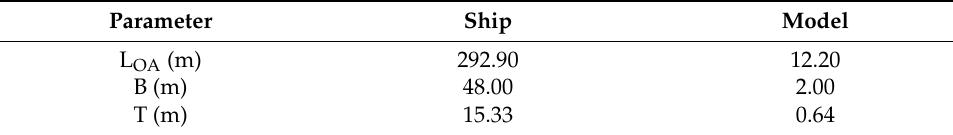
Table 2. Main particulars of the ship and physical manned model.